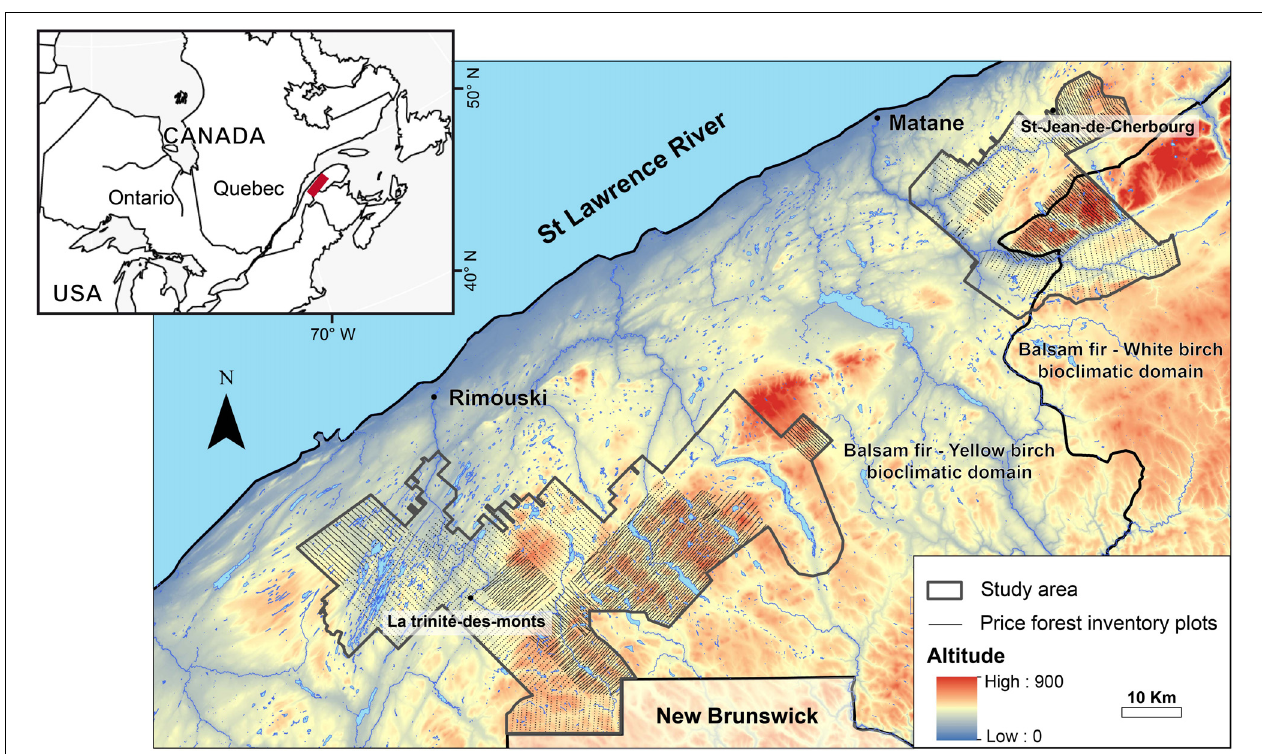
FIGURE 1 | Location of the Rimouski and Matane sectors and distribution of Price forest inventory plots in eastern Canada.